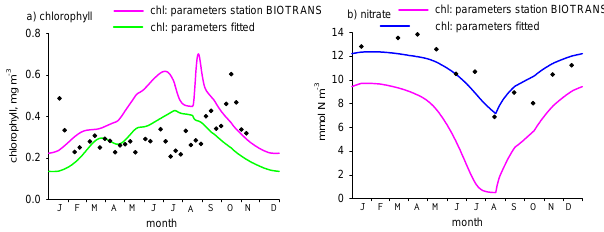
Figure 14. Simulations for station Papa before and after parameter Figure 15. Simulations for station KERFIX before and after param- tuning: (a) chlorophyll, (b) nitrate. Data are for year 2007. eter tuning (see text for details): (a) chlorophyll, (b) nitrate. Data are for year ( 0 ) = 1.25 g C (g chl) − 1 h − 1 and we therefore assigned V max P